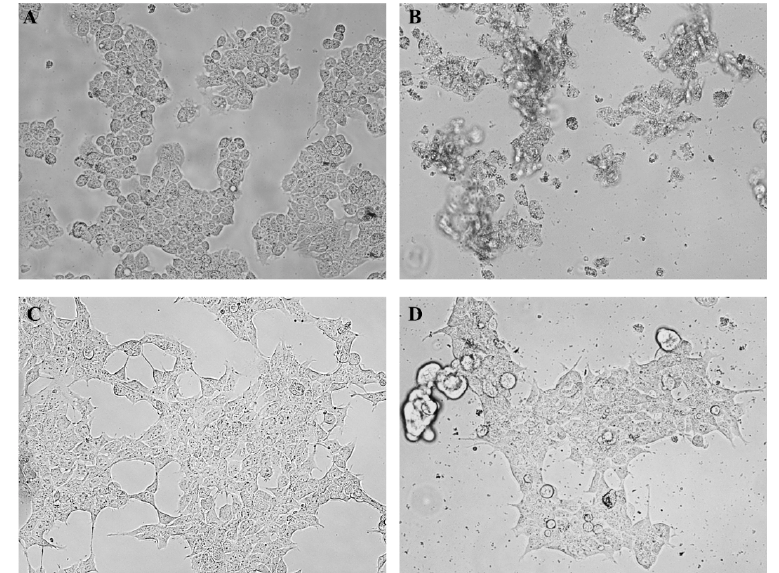
Figure 2. Effect of crude oregano EO on both HepG2 and HEK293 cell morphology. The photographs were taken at a magnification × 40. Images are representative of three independent experiments. Where: ( A ) HepG2 (control); ( B ) HepG2 cells treated with oregano EO (236 µg/µL); ( C ) HEK293 (control) and ( D ) HEK293 cells treated with oregano EO (236 µg/µL).